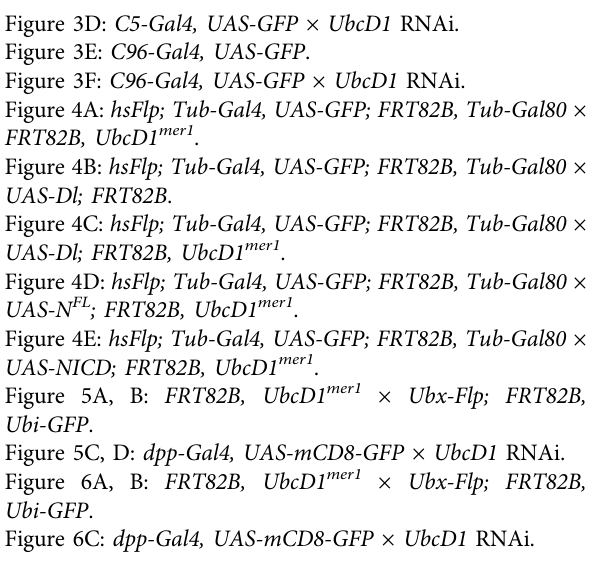
Figure 6D: dpp-Gal4, UAS-mRFP × tub-GFP-LAMP1; UbcD1 RNAi. Figure 7A: hsFlp; Tub-Gal4, UAS-GFP; FRT82B, Tub-Gal80 × UAS-UbcD1 WT ; FRT82B, UbcD1 mer1 . Figure 7B: hsFlp; Tub-Gal4, UAS-GFP; FRT82B, Tub-Gal80 × UAS-UbcD1 C85A ; FRT82B, UbcD1 mer1 . Figure 7C, F: dpp-Gal4, UAS-mCD8-GFP × UAS-UbcD1 WT ; UbcD1 RNAi. Figure 7D, G: dpp-Gal4, UAS-mCD8-GFP × UAS- UbcD1 C85A ; UbcD1 RNAi. Figure 7E: dpp-Gal4, UAS-mCD8-GFP × UbcD1 RNAi. Immunostaining and